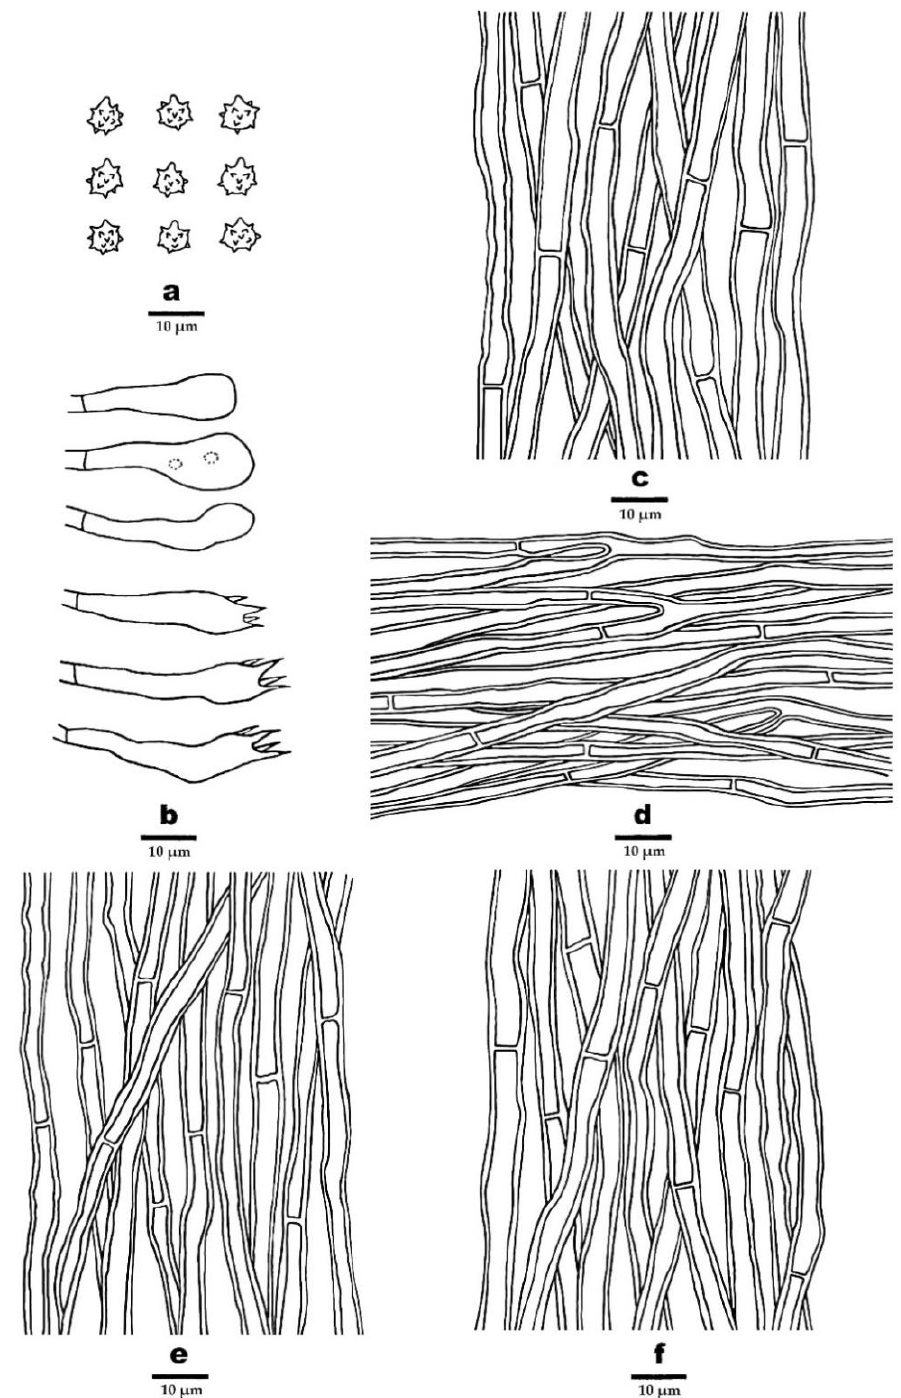
Figure 6. Microscopic structures of P. concentricus (drawn from the holotype). ( a ) Basidiospores, ( b ) Basidia and basidioles, ( c ) Hyphae from context, ( d ) Hyphae from spines, ( e ) Hyphae from inner layer of stipe, and ( f ) Hyphae from surface layer of stipe.